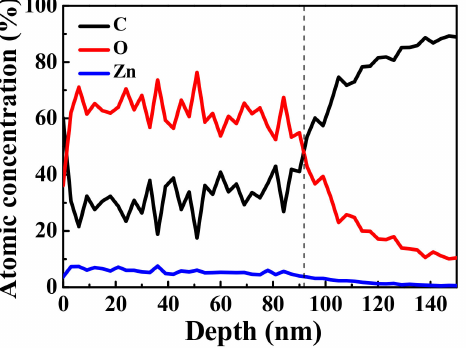
Figure 6. XPS spectra of C, O, and Zn distributions vs. depth (sputtering time) of ZnO/graphene/ PET